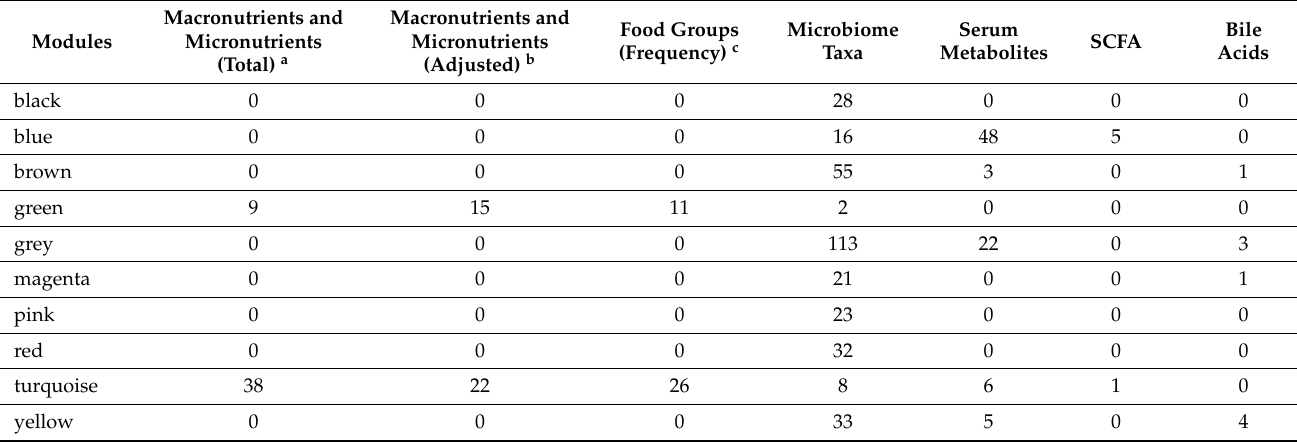
Table 2. Differential association of modules with specific feature